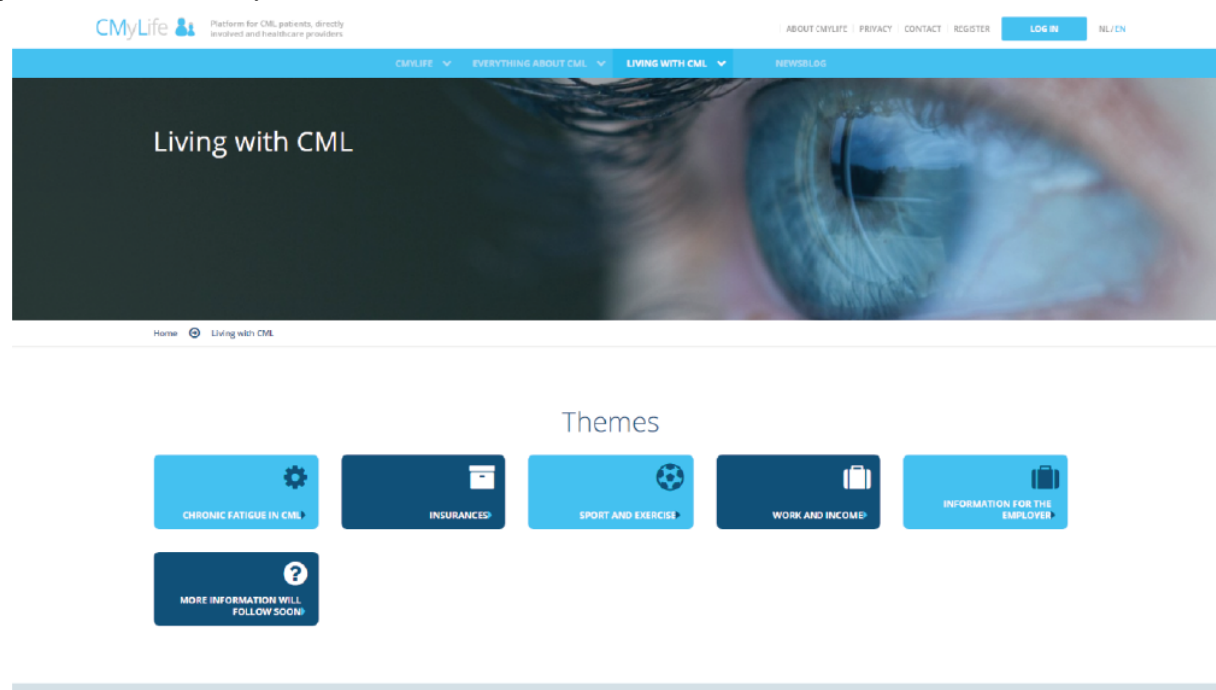
Figure 3. Screenshot of the CMyLife